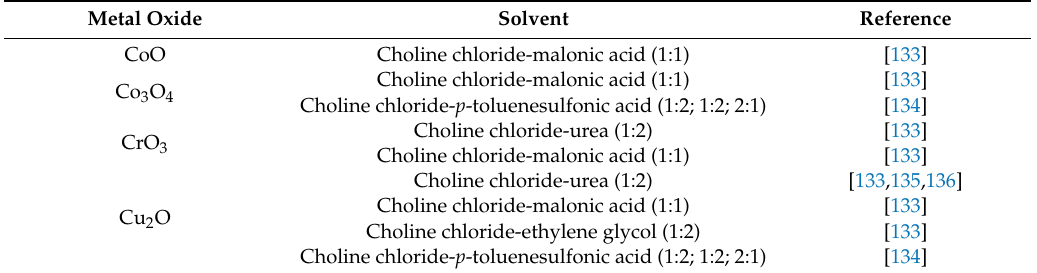
Table 3. Overview about metal oxides dissolved in di ff erent DESs as well as corresponding